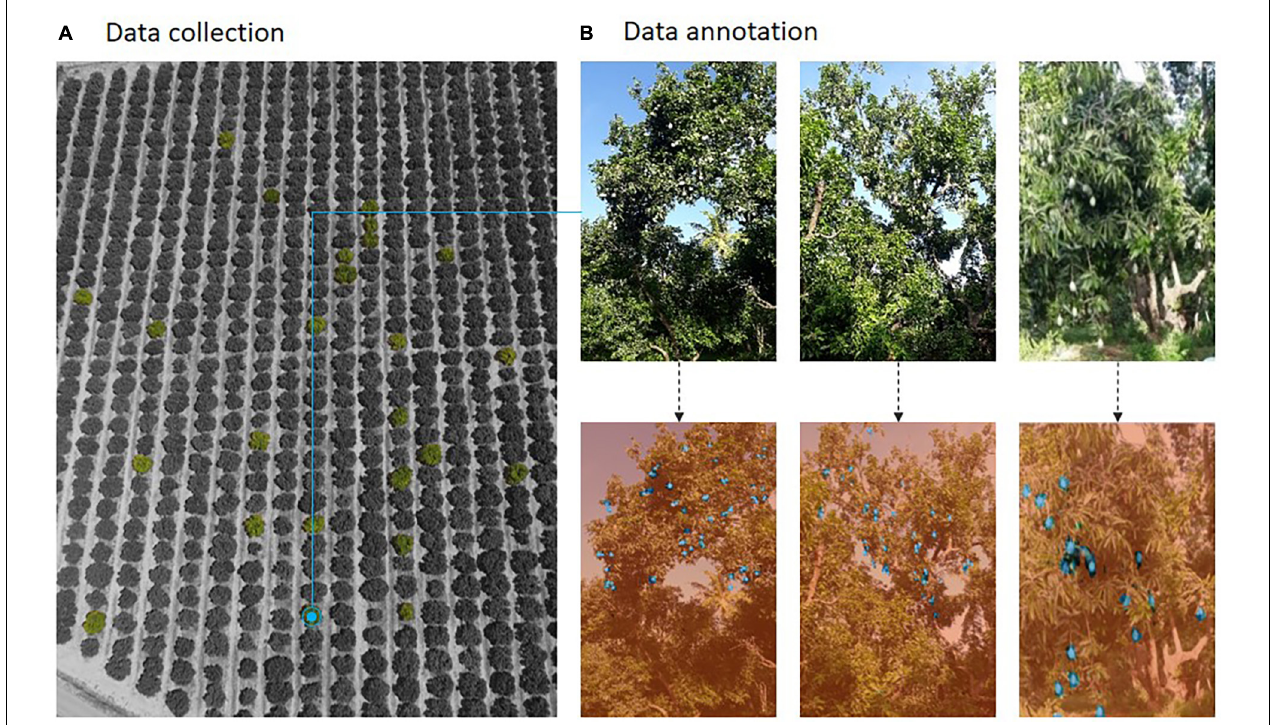
FIGURE 9 | Data collection and